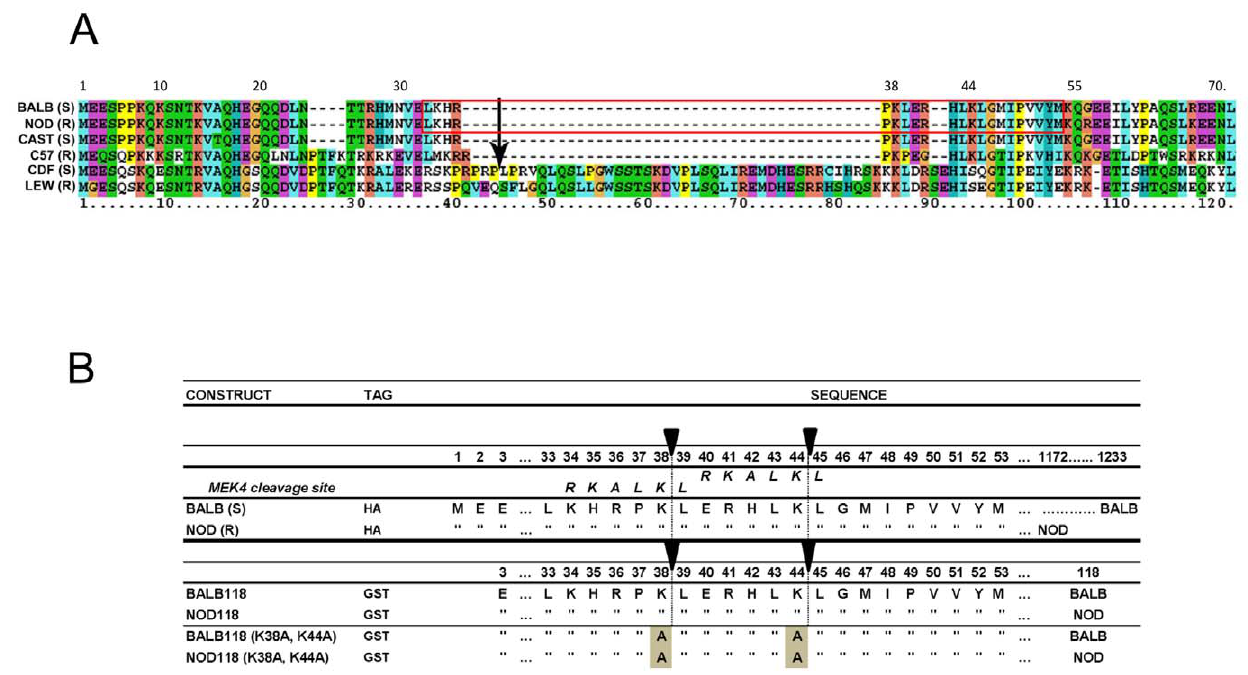
Figure 1. Nlrp1 protein alignments and constructs. (A). Alignment of amino acid sequences from the N-terminus of mouse Nlrp1b and rat Nlrp1 proteins. Sequences shown are those of 4 mouse and 2 rat strains, including strains having macrophages that are either sensitive (S) or resistant (R) to LT. The previously identified LT cleavage site after residue 44 in rat CDF Nlrp1 is indicated by an arrow. The red box indicates the region of mouse sequence shown in (B). (B) Nlrp1b constructs used in this study with focus on N-terminal regions containing putative LF cleavage sites. The top two constructs represent the full-length HA-tagged Nlrp1b proteins from the LT-sensitive Balb/cJ (BALB) and the LT-resistant NOD/LtJ (NOD) macrophages, which were expressed in HT1080 cells. Full length NOD Nlrp1b is shorter (1172 aa) than BALB Nlrp1b due to a region downstream of the leucine rich repeat domain that is missing in this protein. The next four constructs represent proteins where aa 3-118 of Nlrp1b were expressed and purified from E. coli as N-terminal GST-tagged proteins. These proteins also contain a C-terminal His6 tag (not represented in figure). In the sequence alignments, residues identical to those in the construct listed above are indicated by quotation marks (‘‘). Putative LF cleavage sites based on previously described motifs are drawn as vertical dotted lines below filled arrows. The MEK4 cleavage site is also aligned with both putative Nlrp1b cleavage sites. The last two sequences are those of constructs having two key lysine residues substituted with alanine.